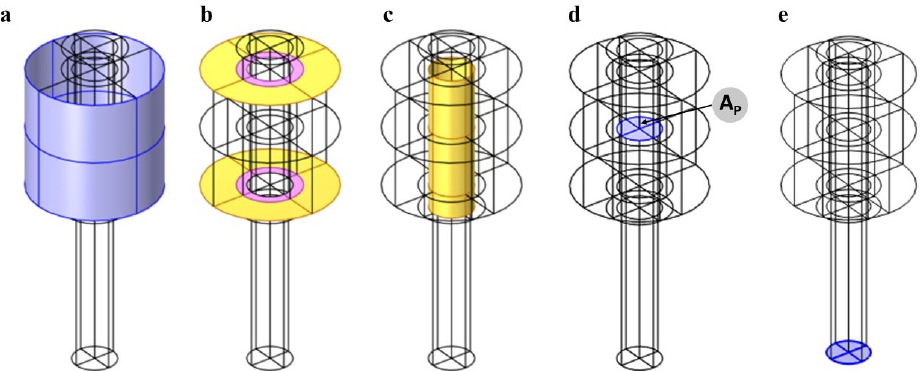
Figure 3. M12 bolt model Boundary Conditions (BC). ( a ) Fixed BC on the exterior surface of the plates. ( b ) Contact BC, where the contact problem is solved for, at the bolt head/plate and nut/plate shared boundaries. ( c ) Contact BC at the threaded region of the plate holes/thread and nut/thread. ( d ) Pre-tensioning load application surface. ( e ) Spring foundation BC.